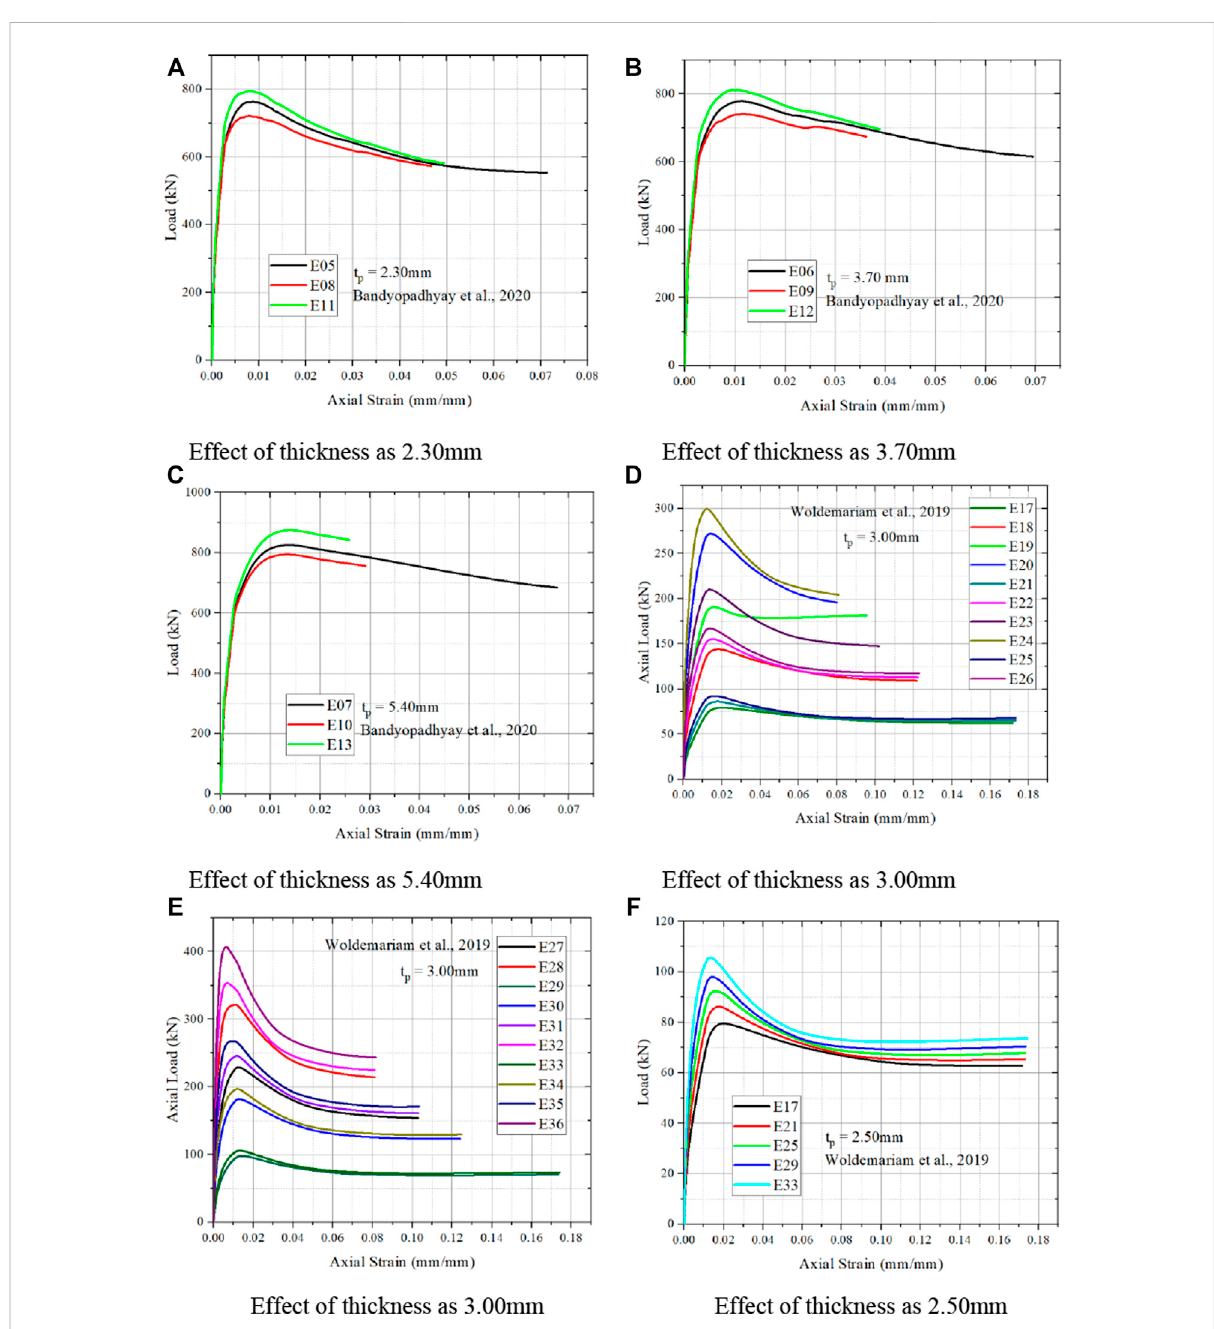
FIGURE 10 EffectofPVCtubethicknessonstressandstrain. (A) Effectofthicknessas2.30 mm. (B) Effectofthicknessas3.70 mm. (C) Effectofthicknessas 5.40 mm. (D) Effect of thickness as 3.00 mm. (E) Effect of thickness as 3.00 mm. (F) Effect of thickness as 2.50